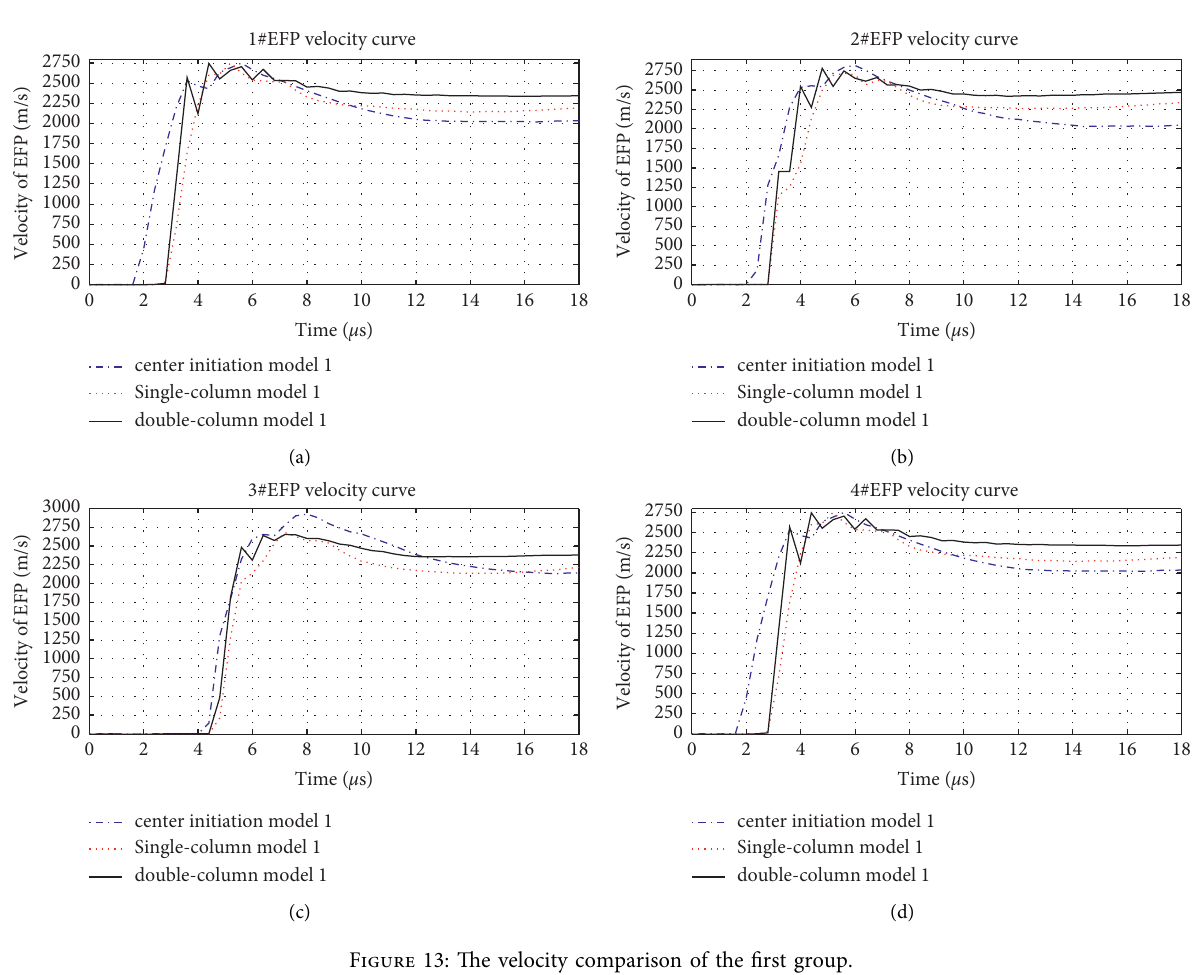
Figure 13: The velocity comparison of the first group.